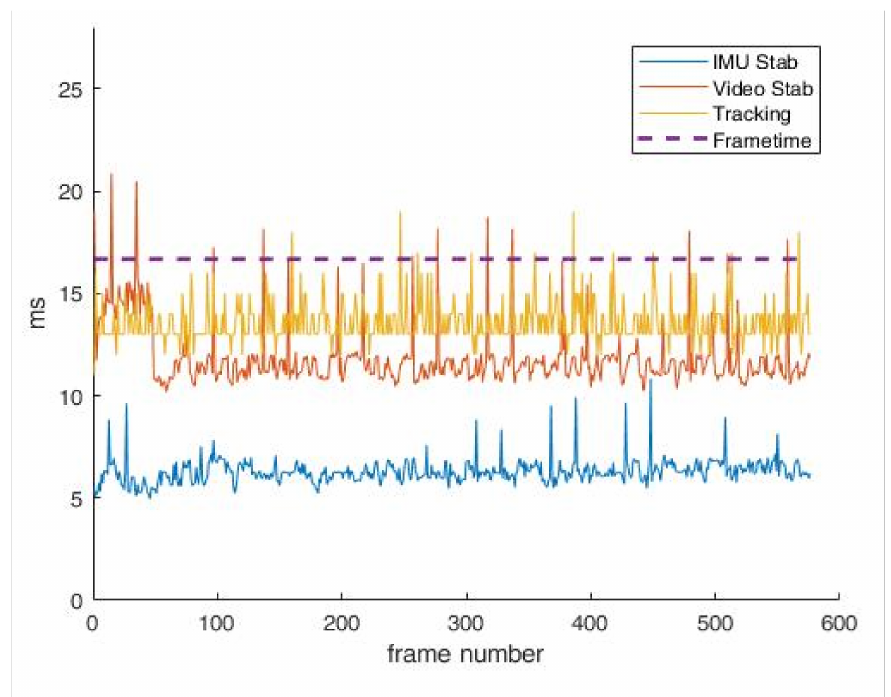
Figure 19. Algorithms’ execution times at video stream of 60 fps in